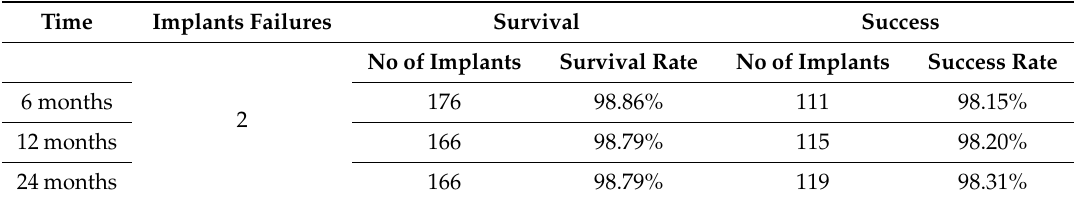
Table 1. Survival (implants that were present at the moment of examination) and success (implants that met the Buser criteria [26]) rates. The rates were calculated according to the number of implants analysed at each